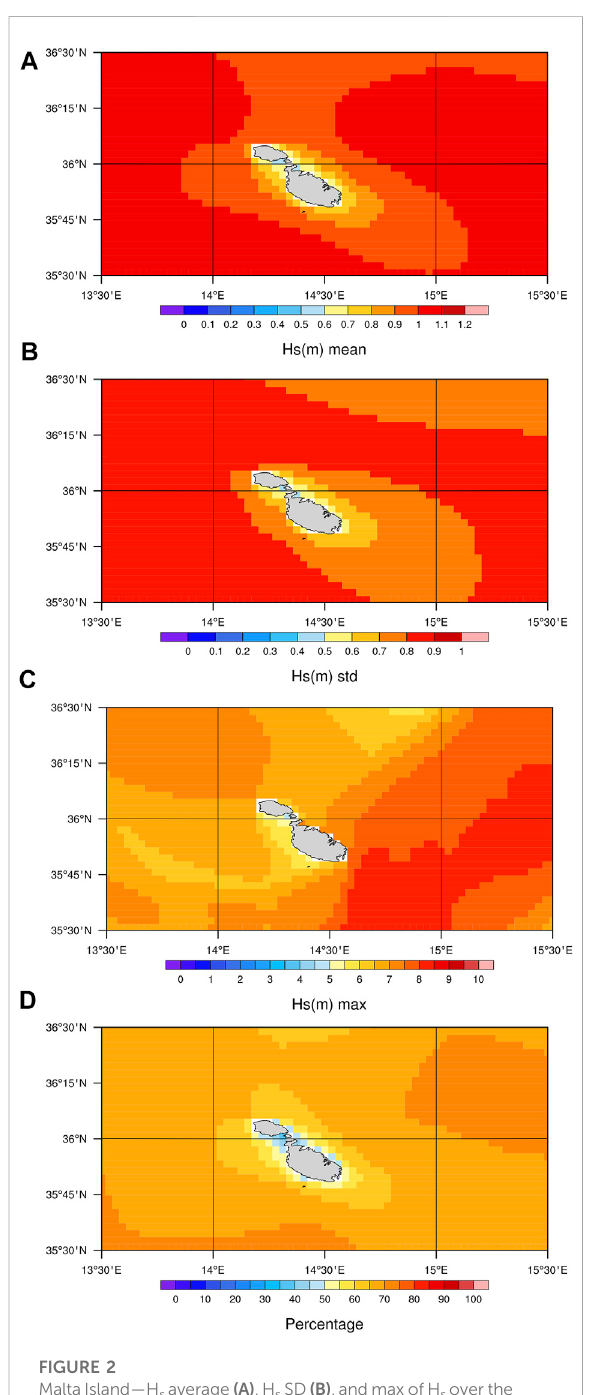
FIGURE 2 MaltaIsland — H s average (A) ,H s SD (B) ,andmaxofH s overthe period 2014 – 2020 (C) ; all values are expressed in meters. Panel (D) : percentage of time spent over the threshold H s = 0.5 m.